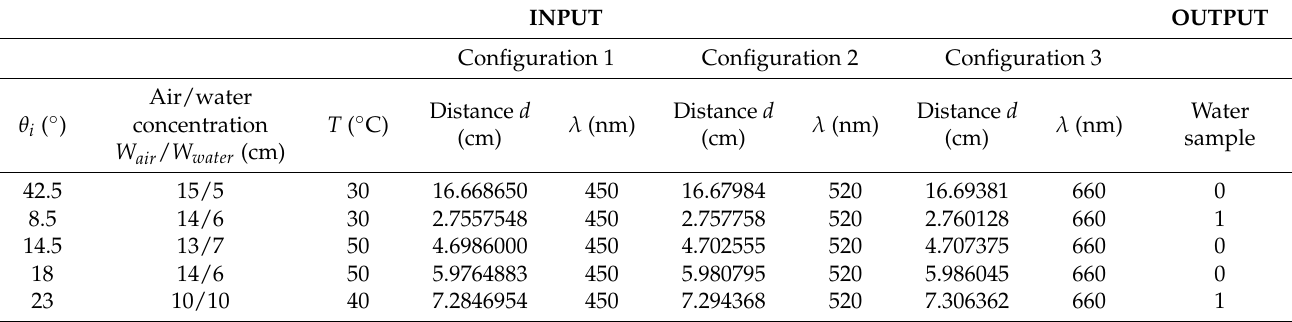
Table 3. Input-output data set